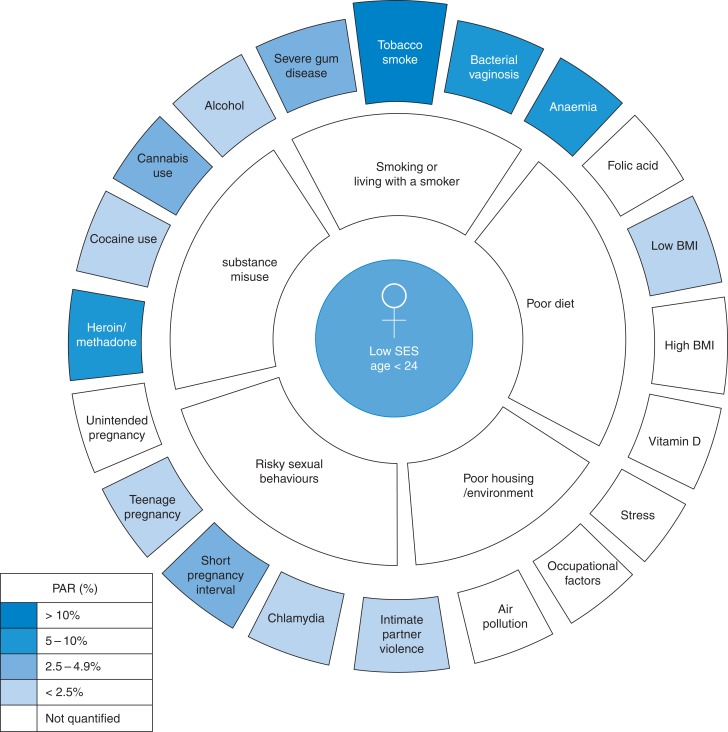
Grouping of individual risk factors around behaviours which place the largest burden of risk on younger mothers.